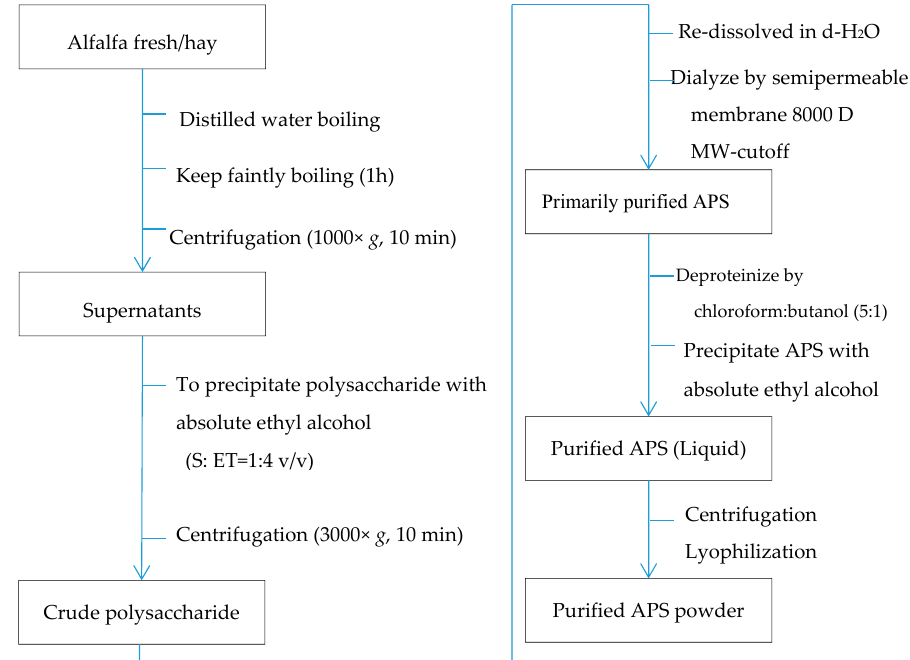
Figure 1. Extraction and purification procedure of alfalfa polysaccharide (APS).